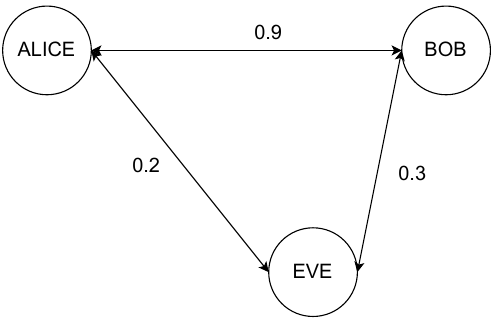
Figure 1. General scheme of Alice, Bob and Eve on the channel: each pair of users sees the channel realizations with a different non-zero correlation. Table 1. Main simulation